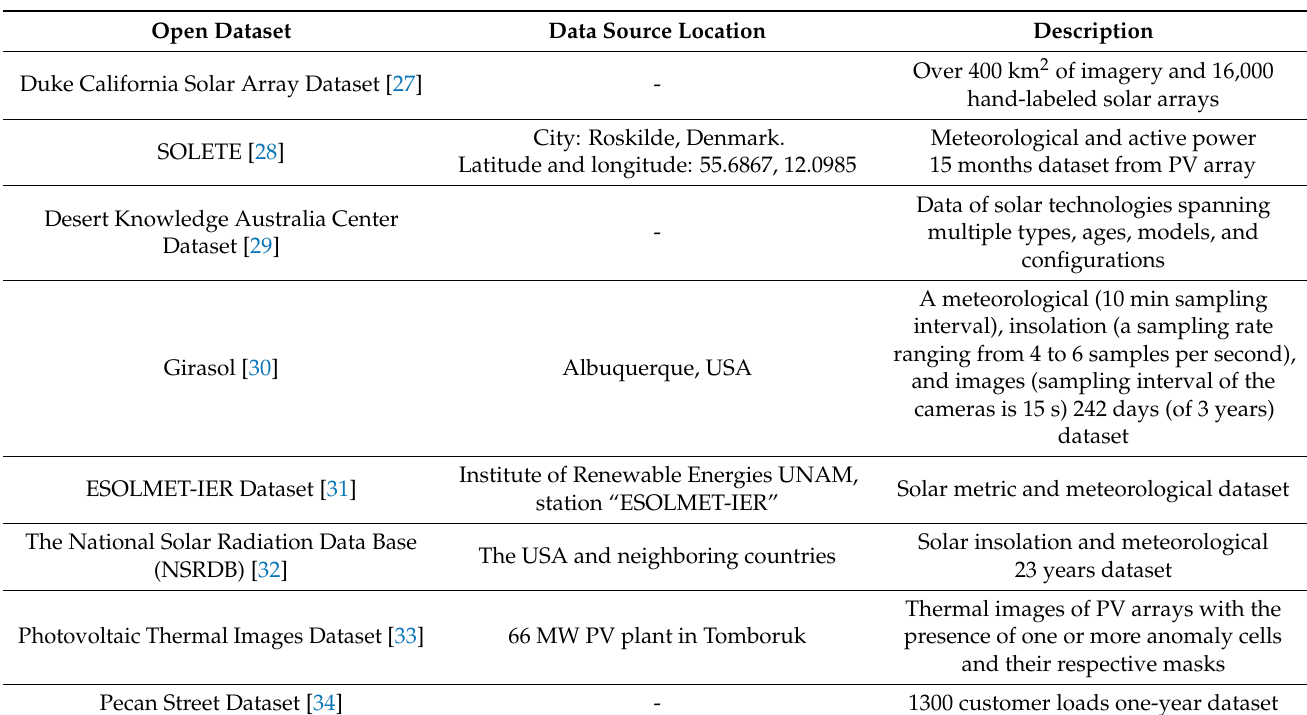
Table 3. Comparison of meta-heuristic